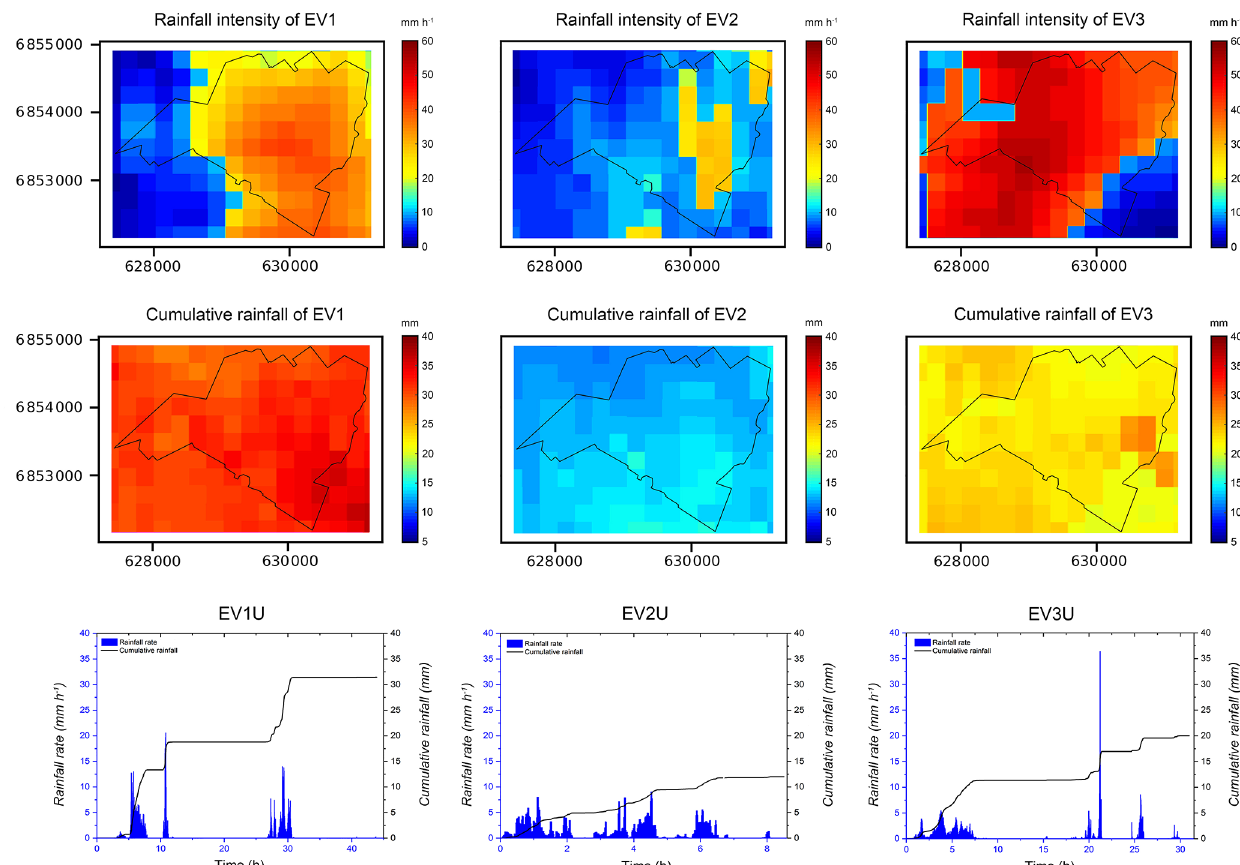
Figure 3. The top row shows the rainfall intensity at the largest rainfall peak (per radar pixel) over the Guyancourt catchment area for the three studied rainfall events, the middle row shows the cumulative rainfall depths (per radar pixel) over the Guyancourt catchment area for the three studied rainfall events, and the bottom row shows the time evolution of rainfall rate (millimetres per hour) and cumulative rainfall (millimetres) of the three uniform rainfall events over the whole